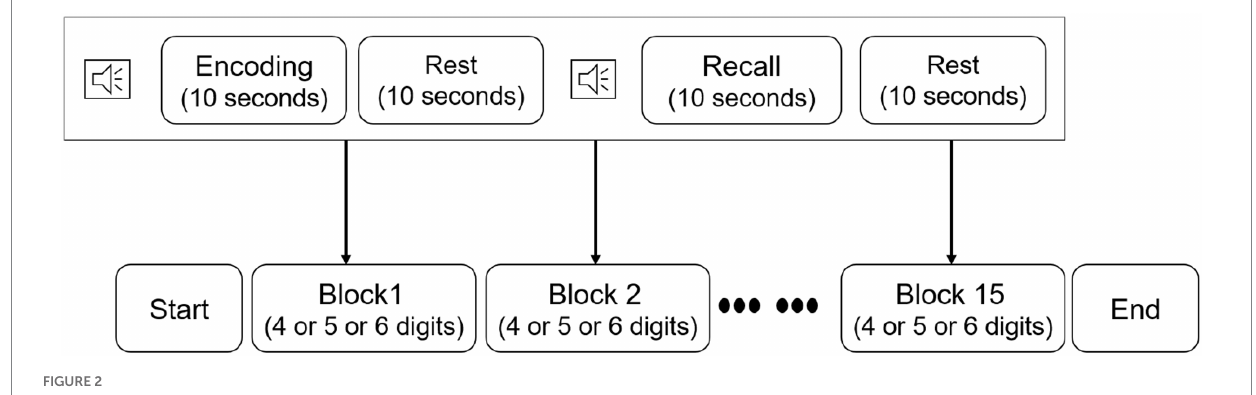
FIGURE 2 The verbal digit span task